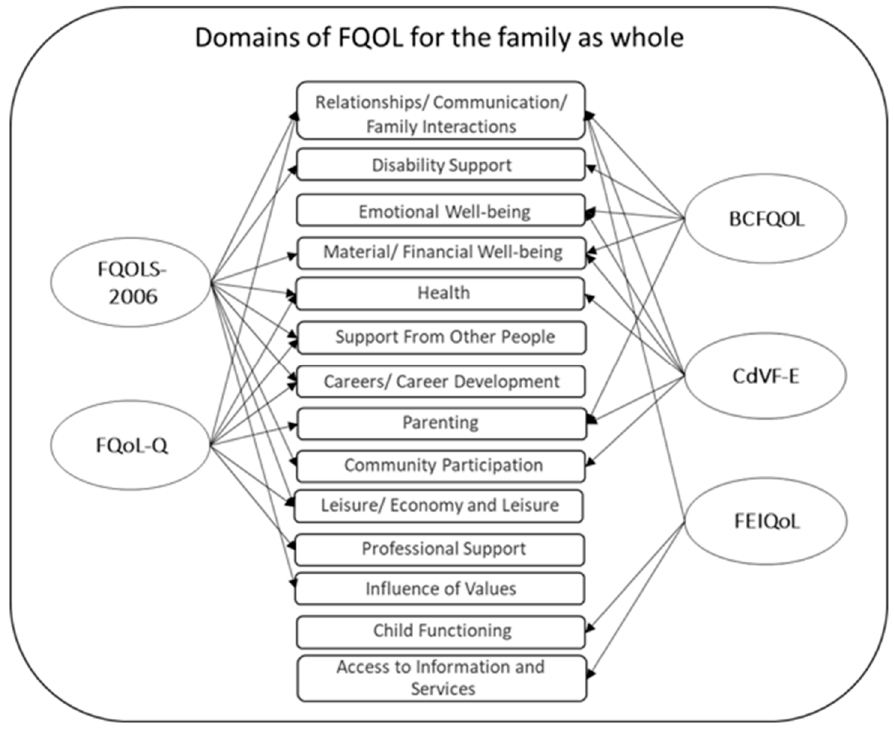
Figure 3. Domains used in the FQoL scales for the family as a whole.